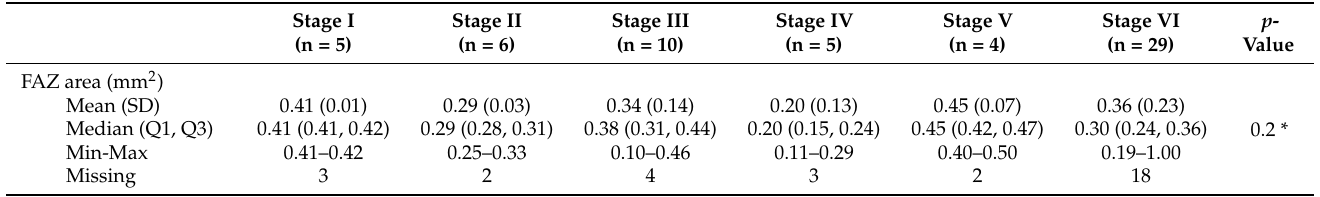
Table 6. FAZ area according to the stage of the